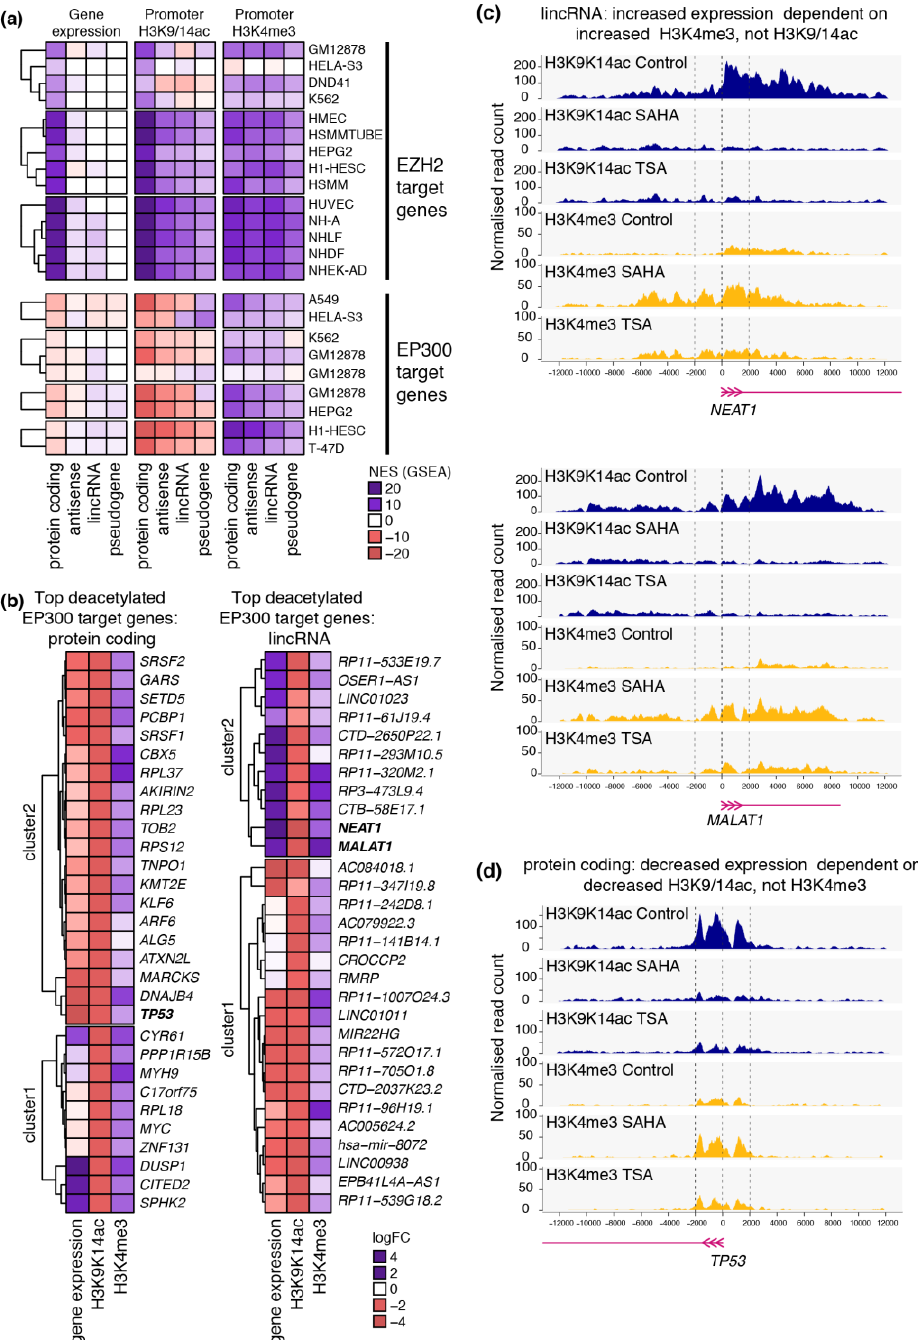
Figure 4. ENCODE-TFBS analysis identified enrichment of EP300 at deacetylated ncRNA promoters. GSEA-ENCODE analysis was used to determine enrichment of transcription factors and chromatin-modifying enzymes at genes regulated by SAHA in HAECs. ( a ) A heatmap showing the normalised enrichment score (NES) for gene sets of EZH2 and EP300 target genes in multiple cell types for coding and non-coding gene expression and histone modifications in HAECs stimulated with SAHA; ( b ) Heatmaps showing logFC of the top EP300 target genes (protein-coding and lincRNA) deacetylated by SAHA and the logFC of the corresponding gene expression and H3K4me3 at gene promoters. H3K9/14ac (blue) and H3K4me3 (yellow) profiles are plotted for the lincRNAs ( c ) NEAT1 and MALAT1 and ( d ) TP53 in control HAECs and those stimulated with SAHA and TSA. Profiles are plotted as the normalised read count and the horizontal axis represents the region surrounding the gene promoter in base pairs.